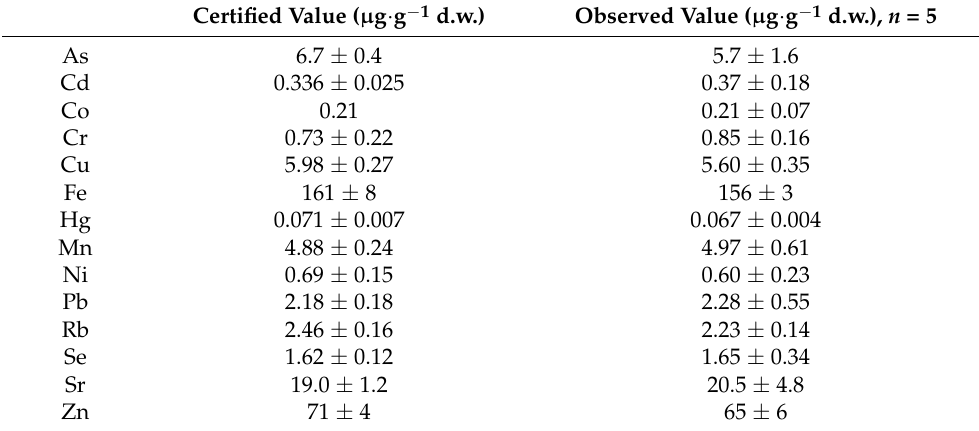
Table 1. Trace element contents in European Reference Material ERM ® -CE278k: Mean value ± uncertainty at the 95% confidence